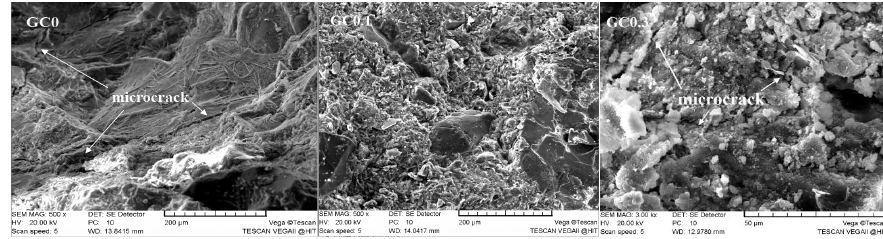
Figure 3. SEM images of the specimens after 30 freeze-thaw tests.